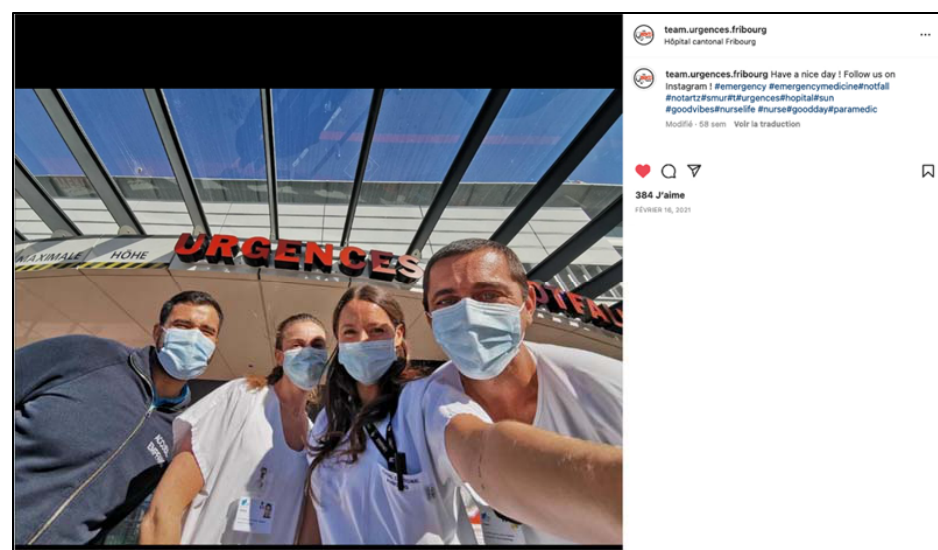
Figure 2. Screenshot of an Instagram “post” illustrating good team cohesion .